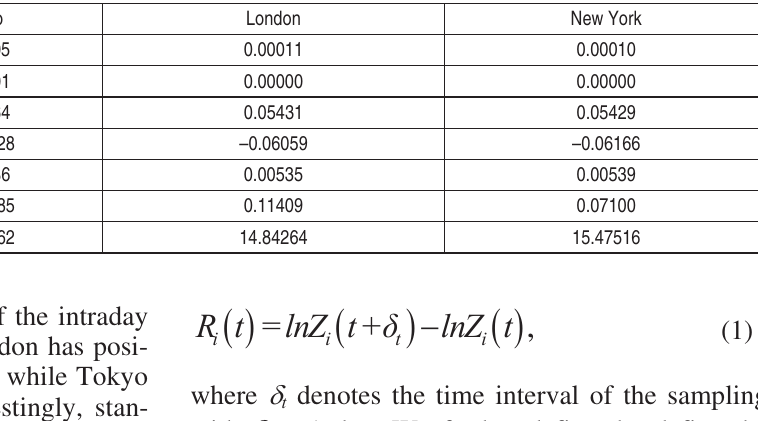
Table 1. Summary statistics of intraday gold returns in Tokyo, London and New York